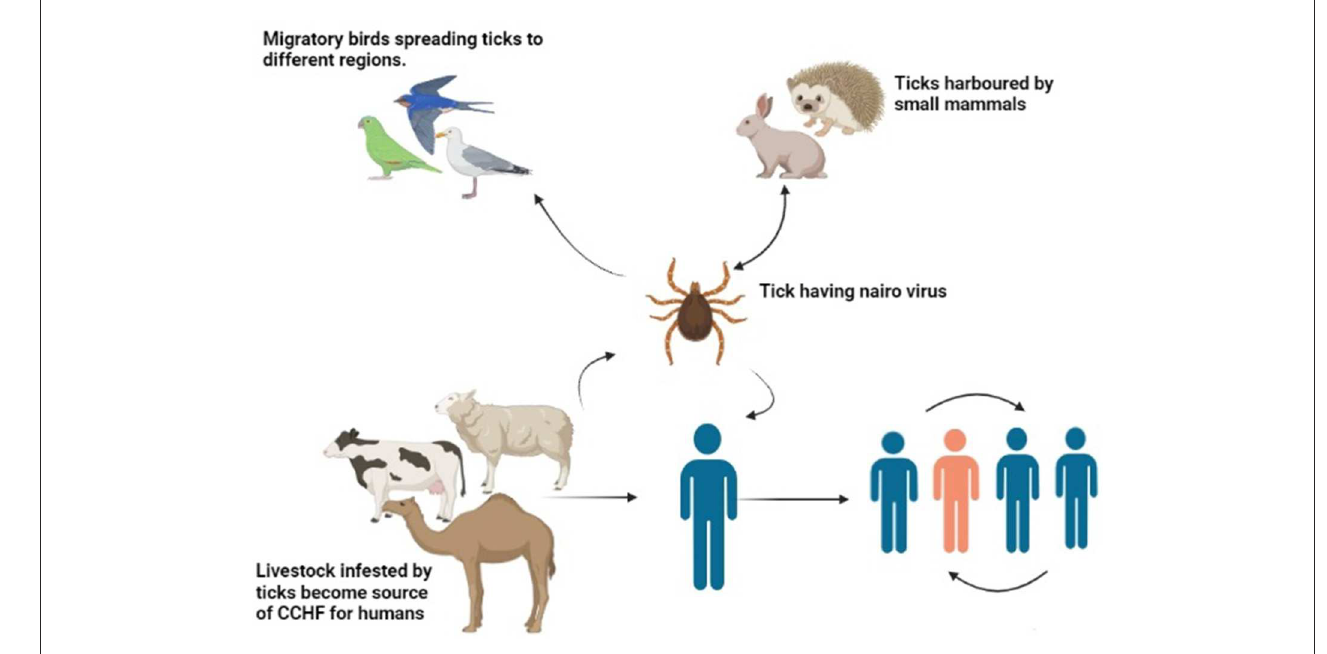
FIGURE3 Transmission of CCHF virus (Drawn by BioRender